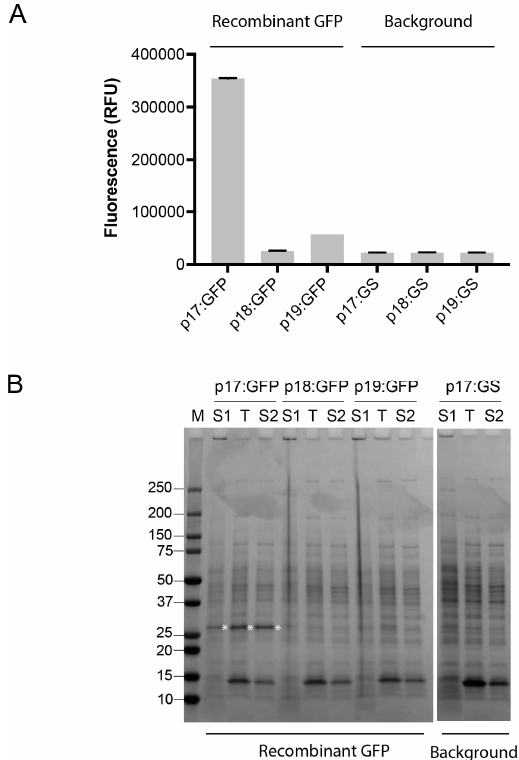
Figure 2. Recombinant expression of green fluorescent protein (GFP) in B. subtilis WB800N. ( A )